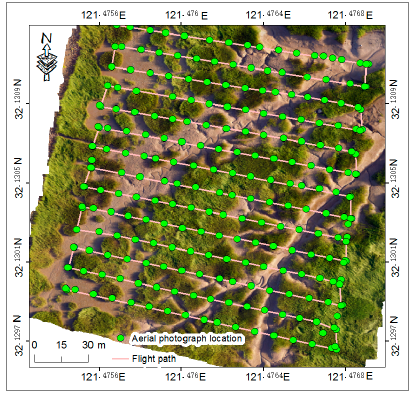
Figure 4. The UAV flight trajectory of the MOSAIC flight mode. The solid green dots are the locations of aerial photographs. The pink line is the flight trajectory of the UAV.